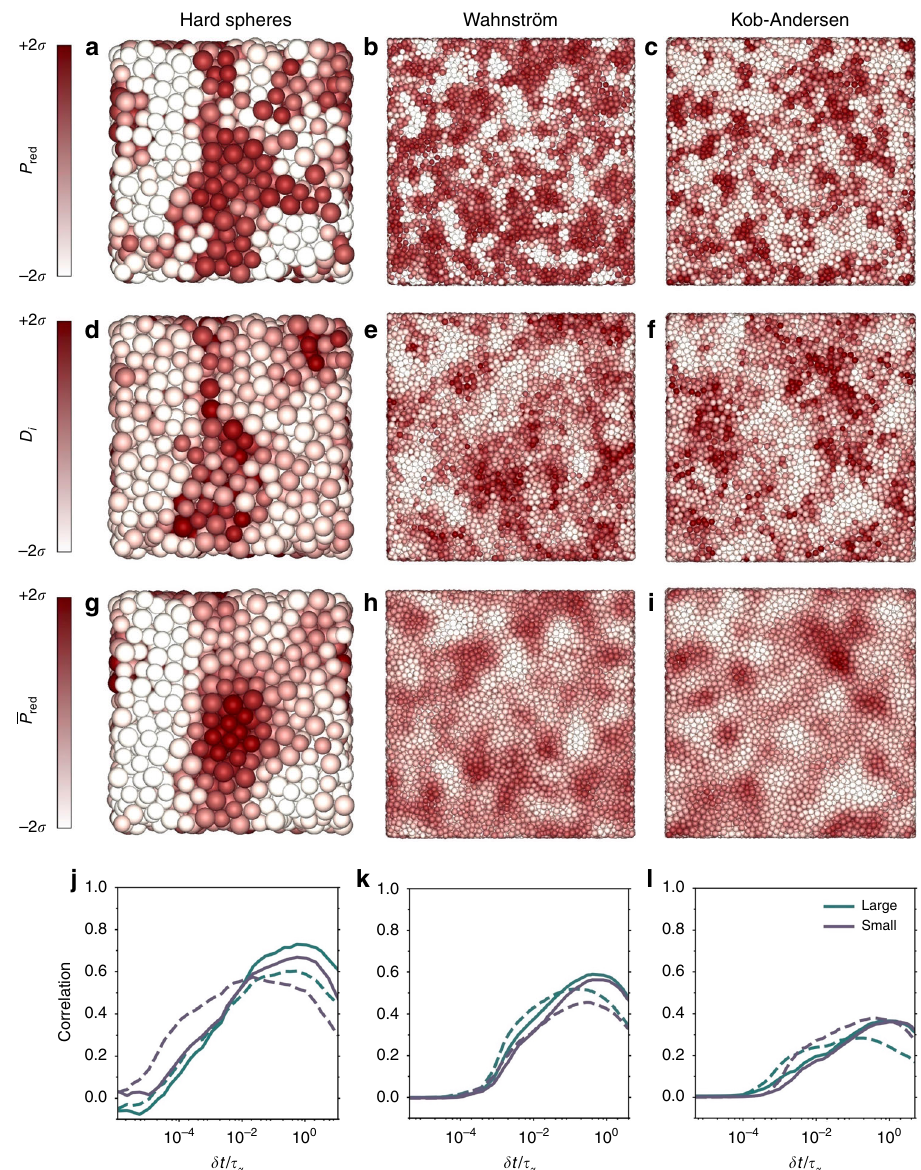
Fig. 3 Structural analysis and correlations with dynamics in three archetypical glass formers. a – c Snapshots of different glassy models. From left to right: hard spheres, Wahnström, and Kob – Andersen at the same state points as Fig. 2. Particles are colored according to their membership probability P red of belonging to a speci fi c cluster identi fi ed by the machine learning approach. In particular, particles whose P red is two or more standard deviations σ above the mean value are dark red, while particles with P red more than two σ below the mean are colored white. d – f Same snapshots as a – c , but colored according to the dynamic propensity D i . g – i Same snapshots, colored according to the locally averaged membership probability (cid:1) P red ð i Þ , where the averaging is over a local spherical neighborhood with a radius of two times the diameter of the spheres of species A . j – l Spearman ’ s rank correlation between the particles ’ dynamic propensity D i and either their membership probability P red ( i ) (dashed lines) or its local average, (cid:1) P red ð i Þ (solid = 2 σ . In all cases, the correlation between the averaged (cid:1) P and D i red